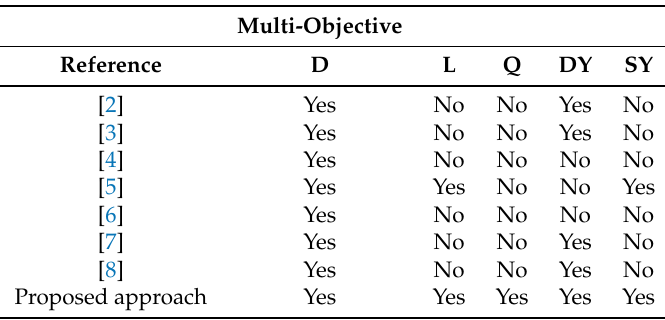
Table 1. Summary of the related works and the proposed method in terms of distance (D), load (L), quality (Q), dynamicity (D), synargy (SY) objectives